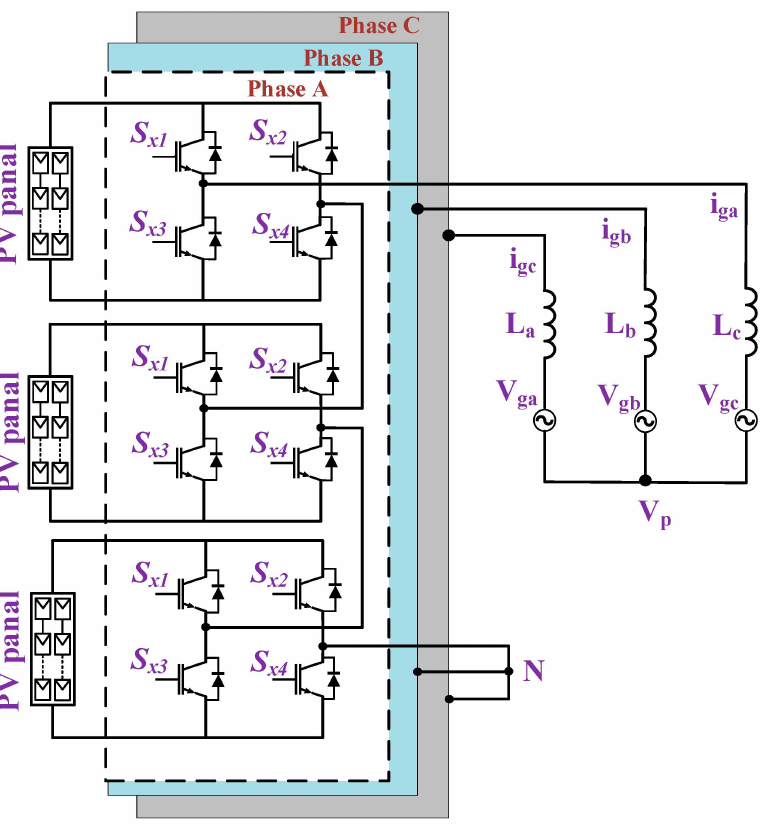
Figure 5. A three-phase CHB MMI